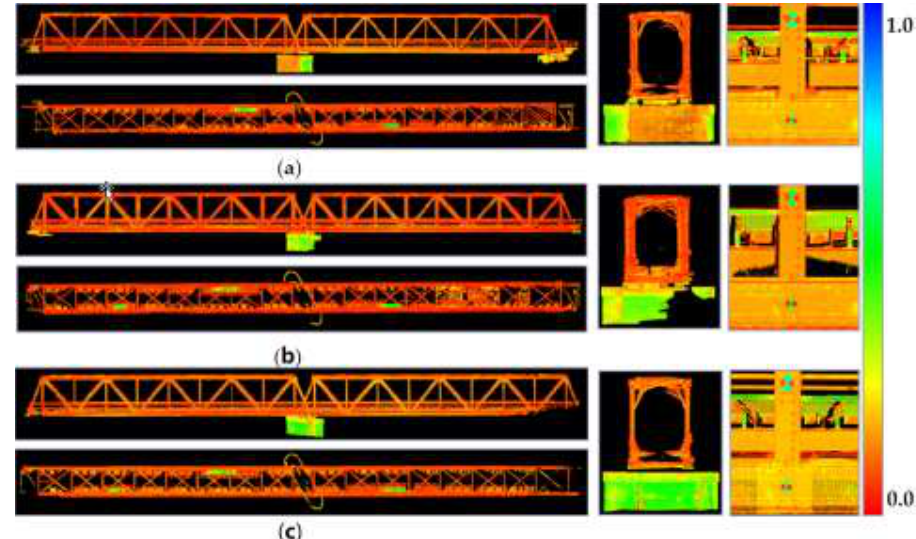
Figure 3. Point clouds of the bridge after registration by using the scale of intensity map (captured by Z + F 5010 and visualized in Leica Cyclone 9.2) in order: back view, top view, cross-section, detail; ( a ) first series; ( b ) second series (TLS data before static loading in [42]; ( c ) third series. Table 7. Results of TLS data and TLS data filtration. MAE: mean absolute error.